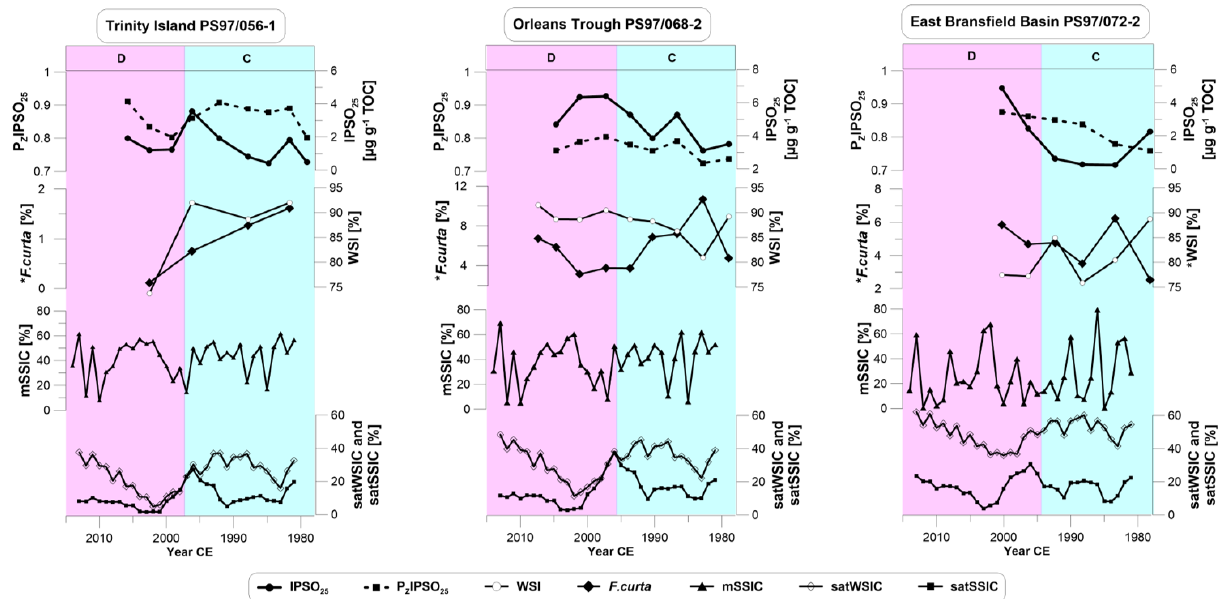
Figure 4. Concentrations of (from top to bottom) IPSO 25 , P Z IPSO 25 , WSI and abundance of F. curta compared to modeled spring sea ice concentrations (mSSIC), and satellite-derived winter and spring sea ice concentrations (satWSIC and satSSIC, 5-year running mean) from the National Snow and Ice Data Center (NSIDC; Cavalieri et al., 1996) for all three core sites. Data marked with * are from the trigger core PS97/072-1. Vertical bars denote the environmental units C and